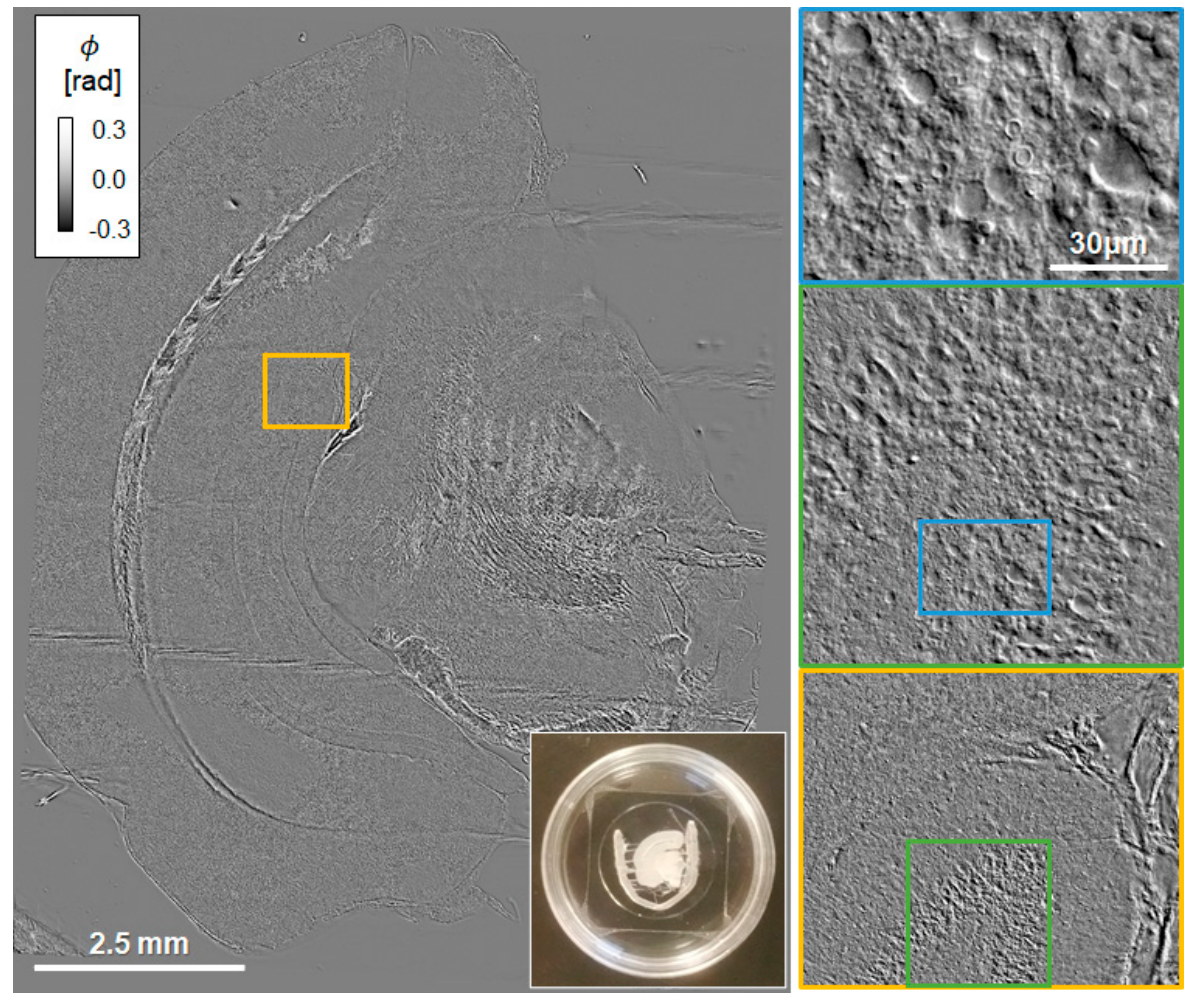
Figure 3. GLIM image of an entire acute brain slice cross-section. The pairs of colored rectangles illustrate zoomed-in regions of interest. The image represents a 40 × 40 tile mosaic, acquired in 15 min (40×/0.75NA objective).